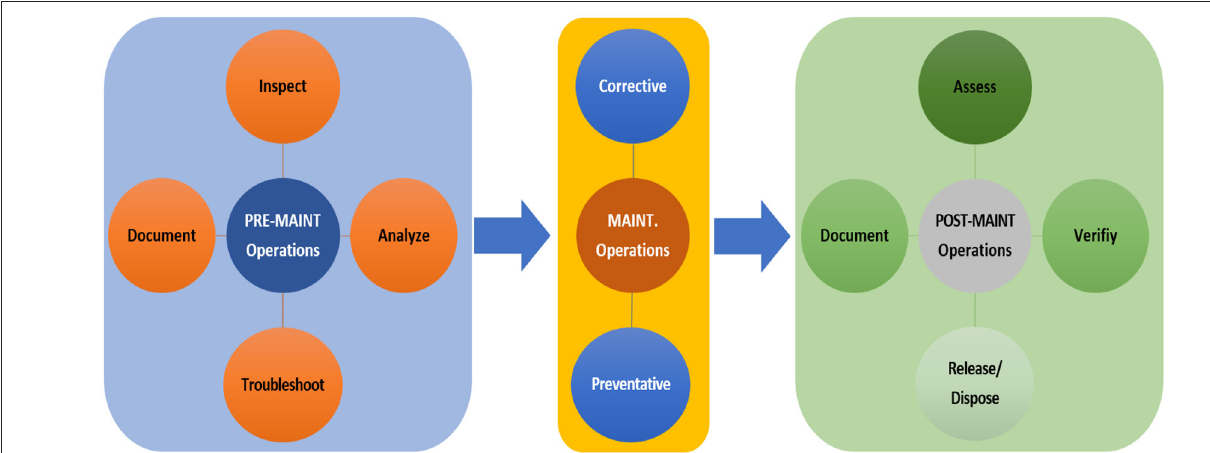
FIGURE 11 | A system maintenance plan for our SOI.